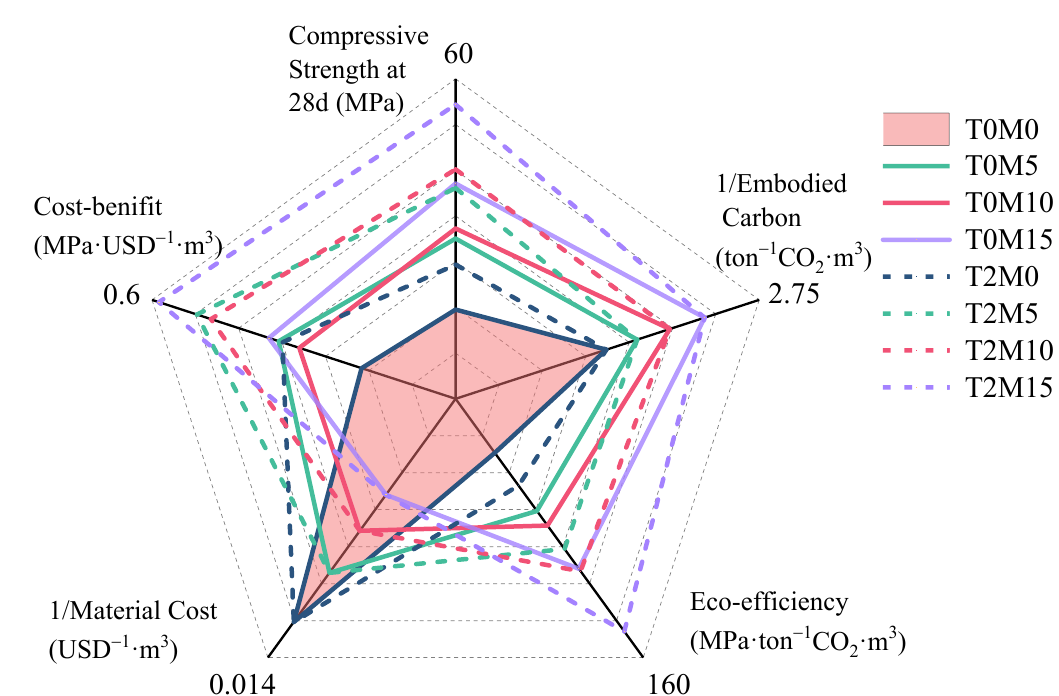
Figure 12. Five-dimensional assessment considering mechanical properties, embodied carbon, eco- efficiency, material cost, and the cost–benefit (strength per unit cost) of blended mortars. The calculated embodied carbon and material cost were based on 1 m 3 of mortars.